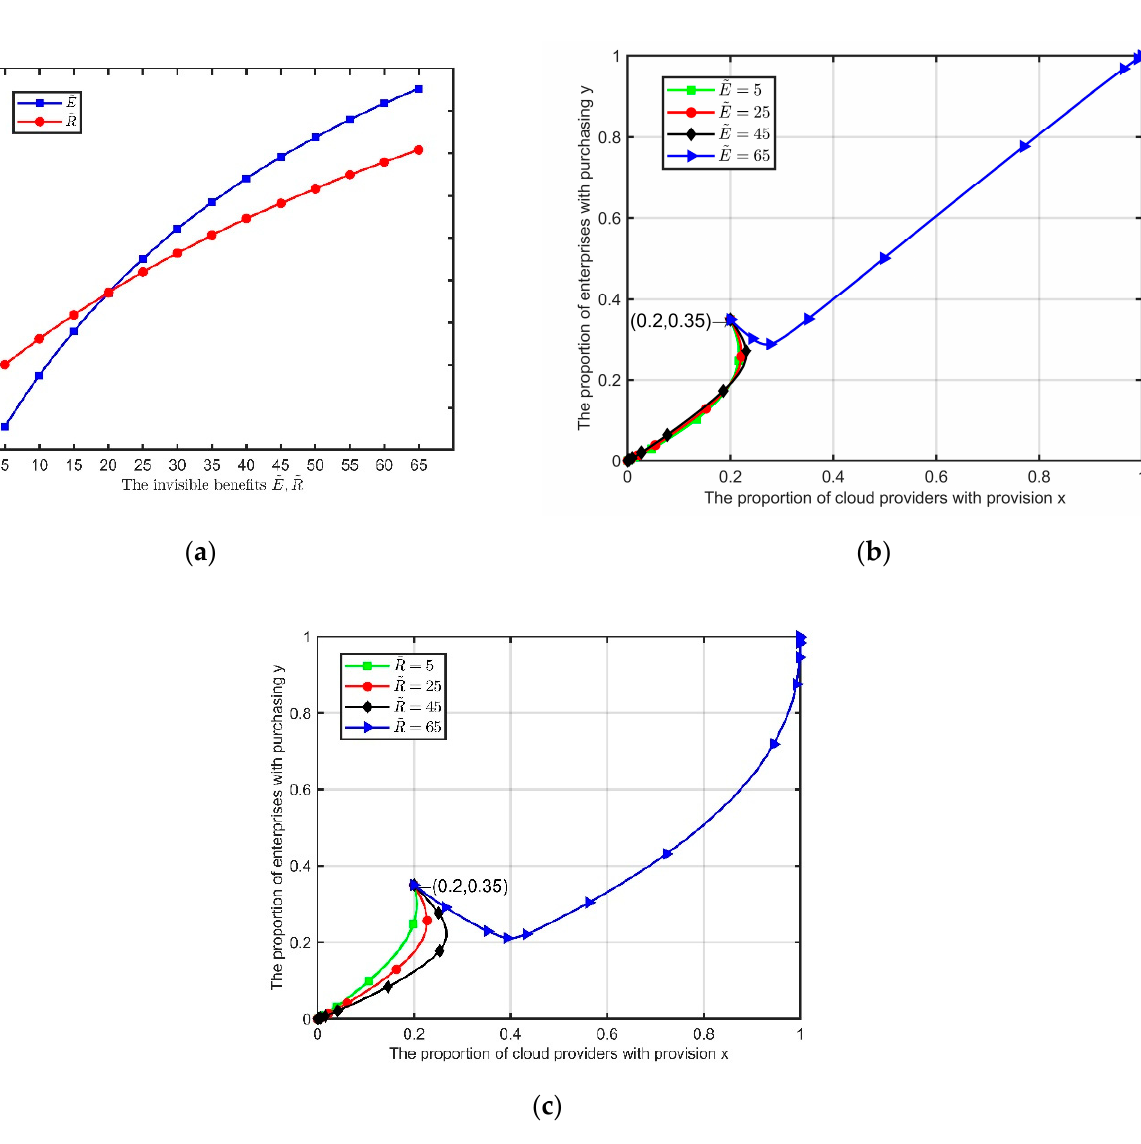
~ ~ Figure 7. The impact of (cid:101) E and (cid:101) R on S II and evolutionary paths ( a ) The impact of (cid:101) E and (cid:101) R on S II ; Figure 7. The impact of E and R on Ⅱ S and evolutionary paths (a) The impact of E ( b ) The evolutionary paths with different invisible benefits (cid:101) E ; ( c ) The evolutionary paths with different on Ⅱ S ; (b) The evolutionary paths with different invisible benefits E invisible benefits (cid:101) R ~ with different invisible benefits R .